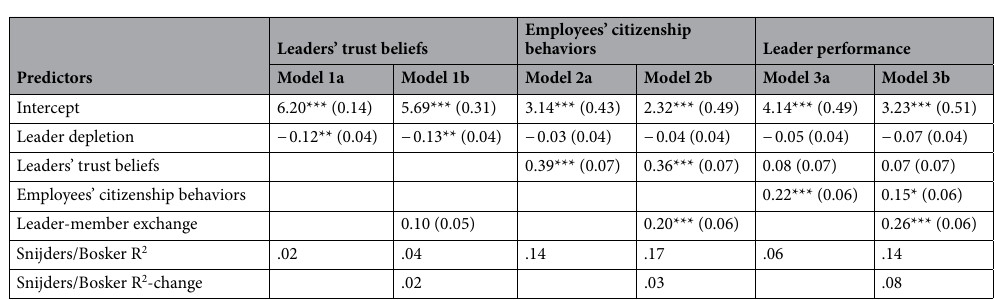
Table 4. Results of the regression analyses (Study 2). Values reflect b with SE between parentheses. Level-1 R 2 ’s are reported. ‘Model a’ refers to the model in which leader-member exchange was not included as a control, whereas ‘Model b’ refers to the model in which leader-member exchange was included as a control. * p < .05. ** p < .01. *** p <